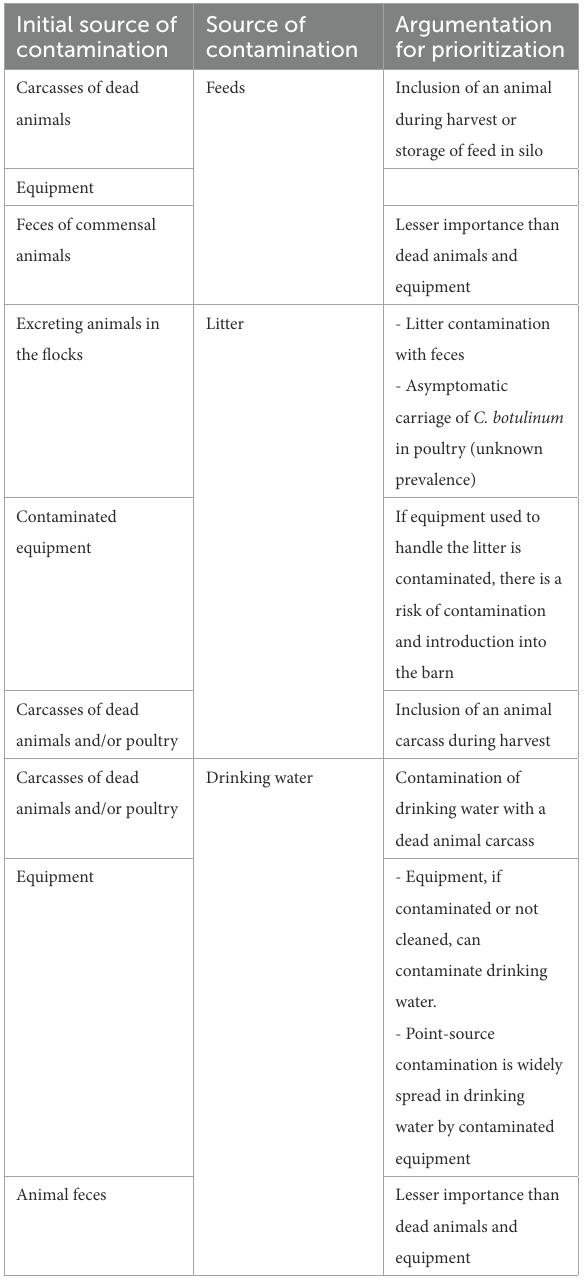
TABLE 7 Prioritization of importance (decreasing order) of the different initial sources and vehicles of C. botulinum contamination (spore, vegetative form and toxins) in a poultry